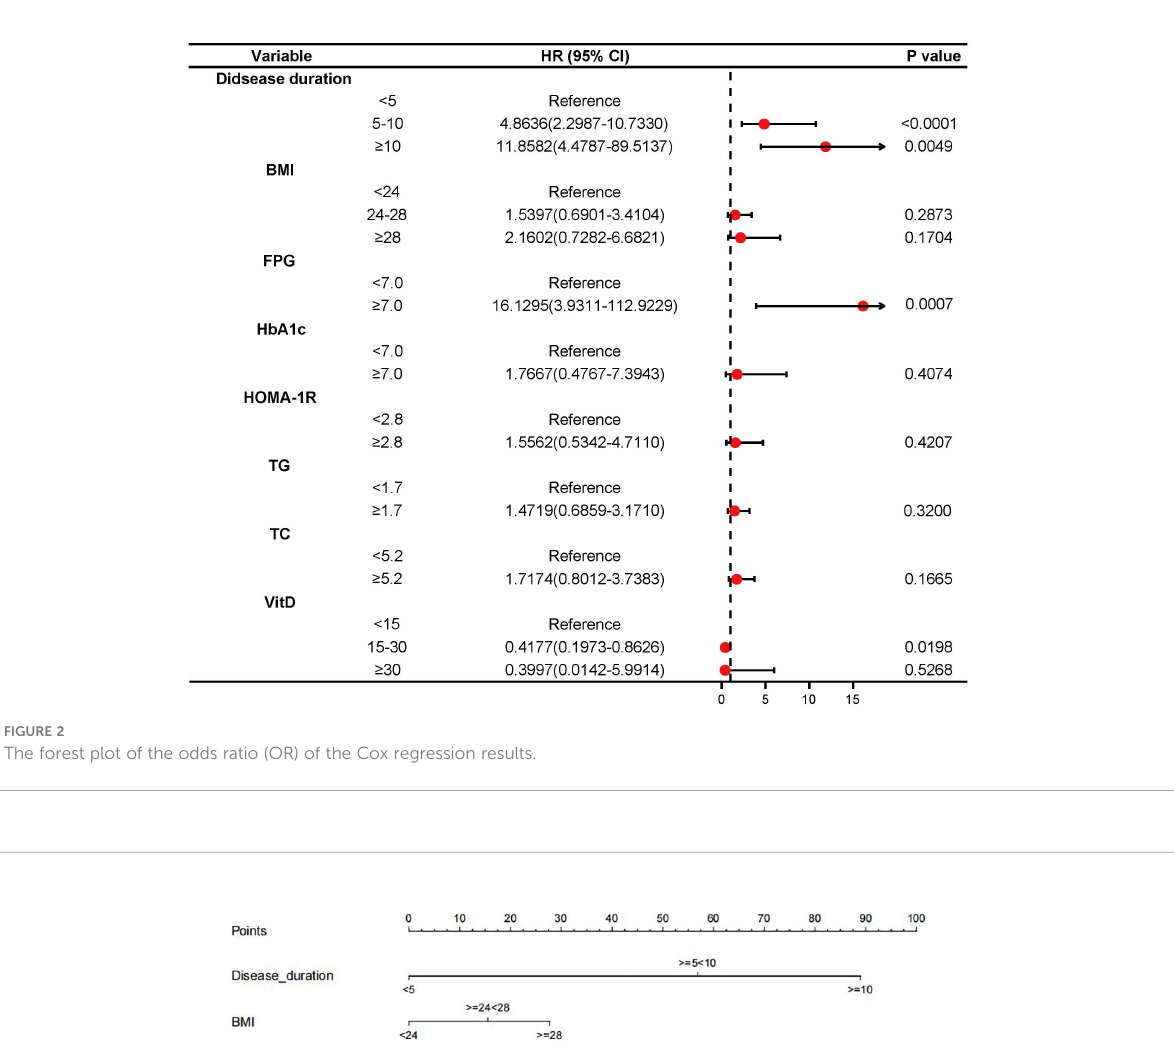
FIGURE 2 The forest plot of the odds ratio (OR) of the Cox regression results.